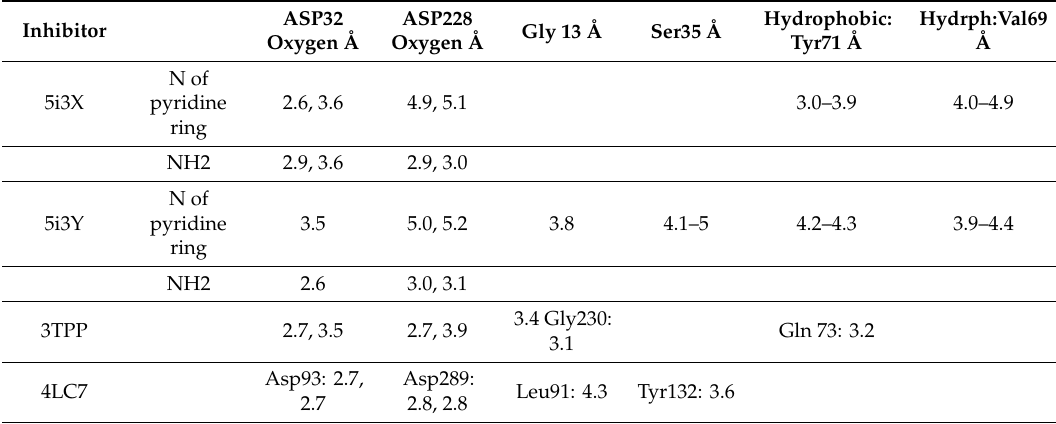
Table 3. Bond distances measured in the average structure using pymol.